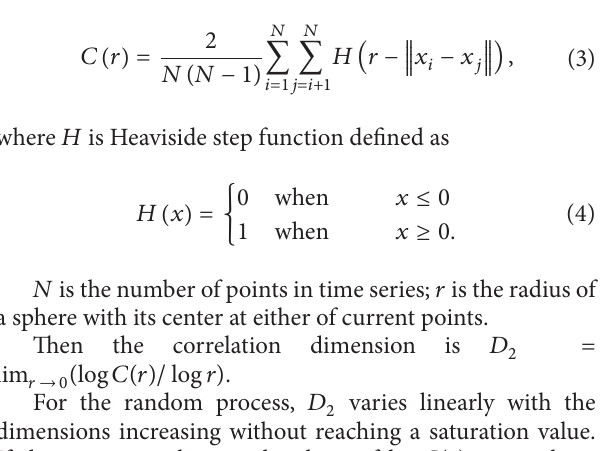
chaotic properties by calculating the dynamic